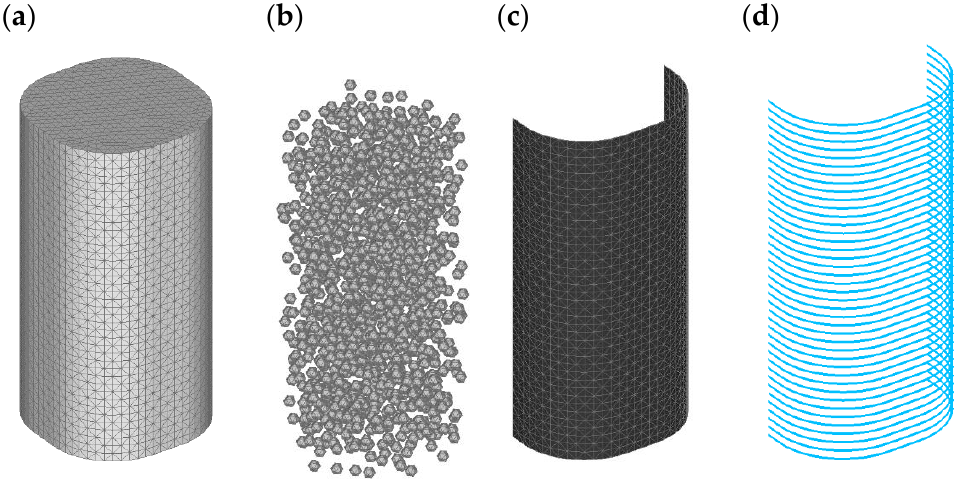
Figure 5. FE model for R 60: ( a , b ) concrete ( c , d ) CFRP.